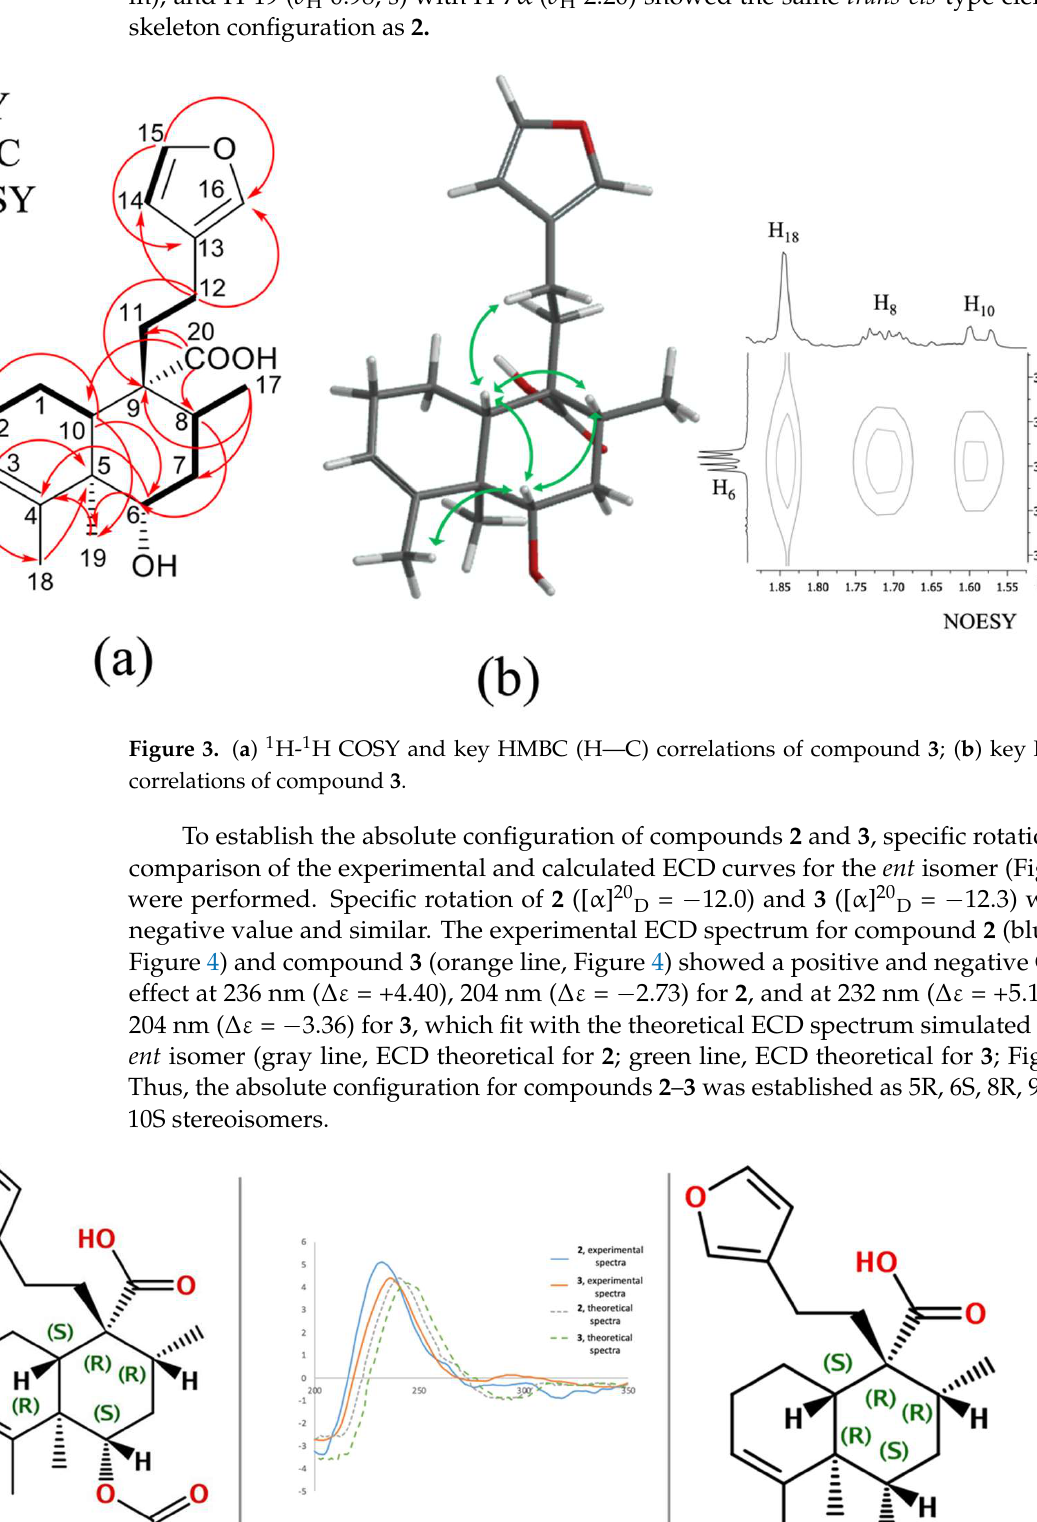
Figure 4. Experimental circular dichroism (CD) spectra for compounds 2 and 3 , in addition to the calculated CD spectra. 2.2. HPLC Phytochemical Profiling HPLC profile of the EWE of C. guatemalensis was monitored at different wavelengths and the peak heights were evaluated. Maximum peak heights for the extract were ob- tained at 205, 240, and 254 nm (Figure 5) and were selected as optimum wavelengths to